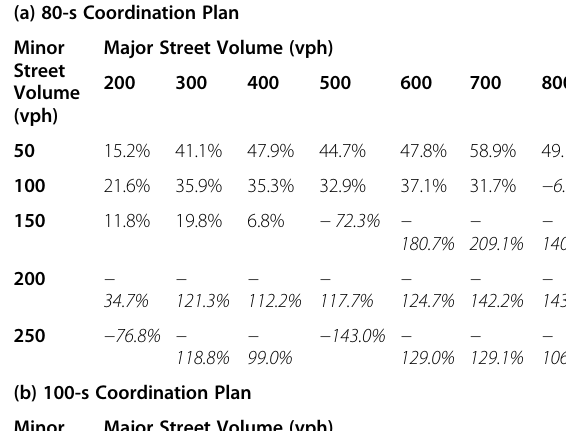
Table 1 Comparison of Simulated Number of Conflicts between Coordinated Signal Plans and Free Signal Operation Scheme at Mill St Percent of Improvement in Number of Conflicts after Implementing Signal Coordination (a) 80-s Coordination